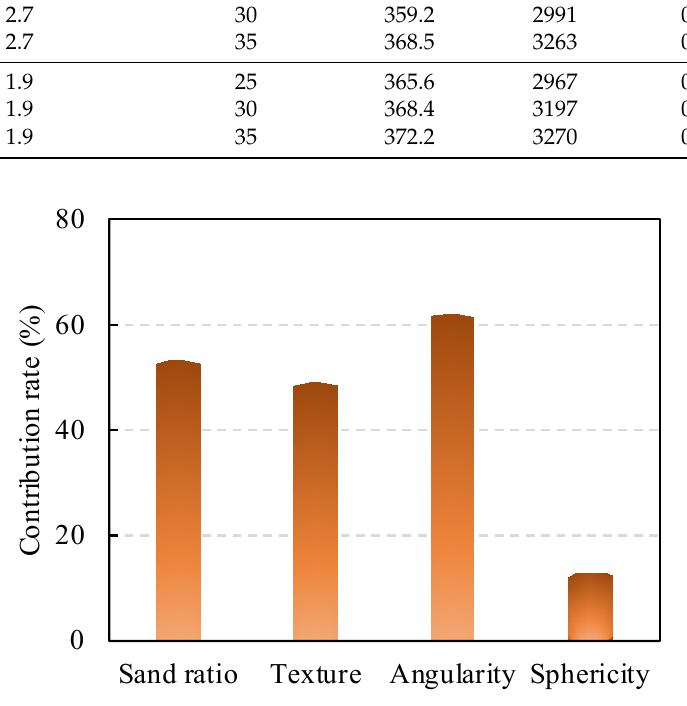
Figure 7. Contribution rate of material properties on K 2